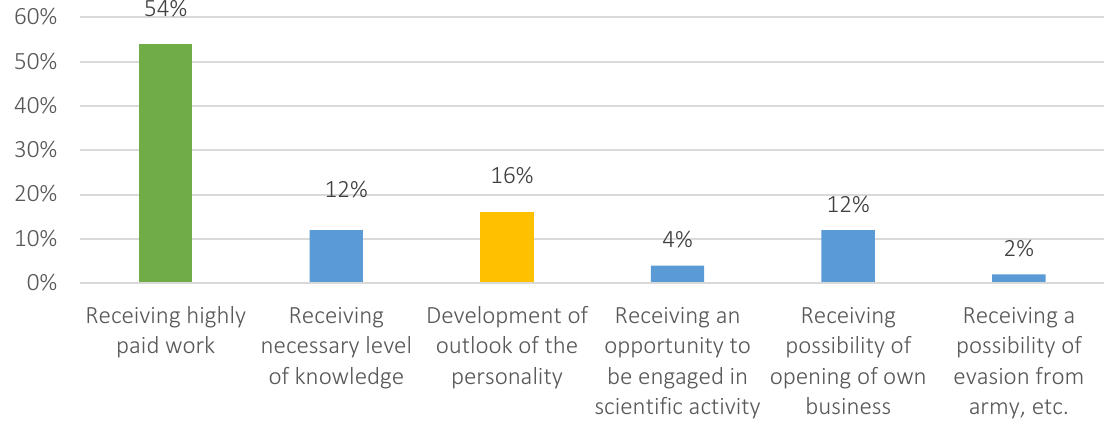
Figure 2. The main objective of receiving the higher education, %